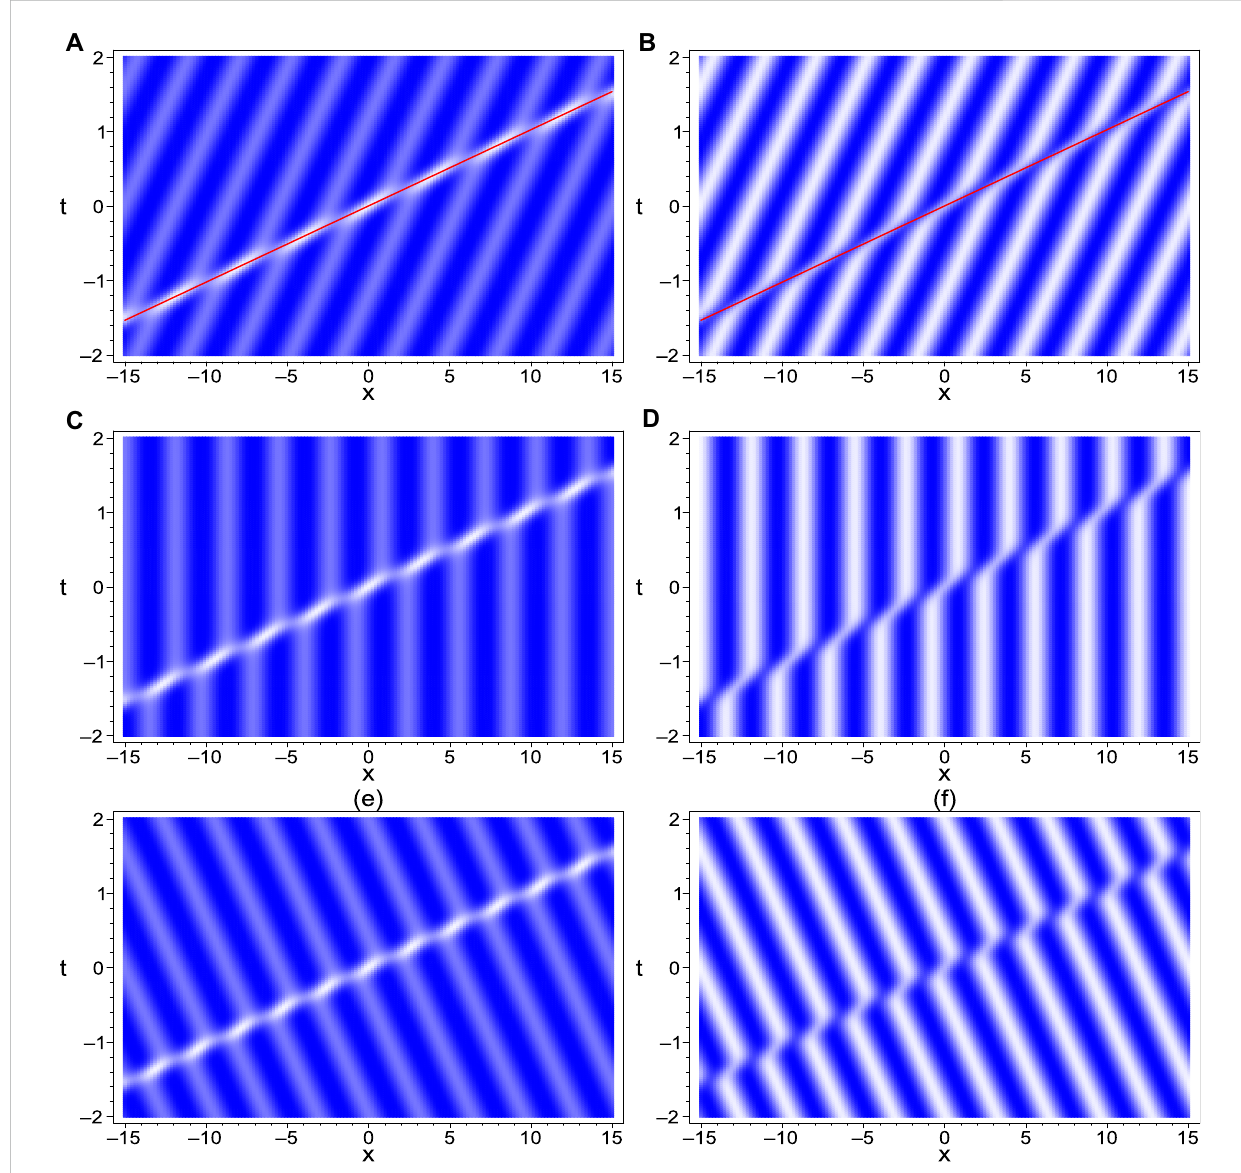
Density pro fi les of the soliton-cnoidal periodic wave with the parameters (A) and (B) ω 0 =2; (C) and (D) : ω 0 =0; (E) and (F) : ω 0 = − 2. Other parameters are the same as those in Figure